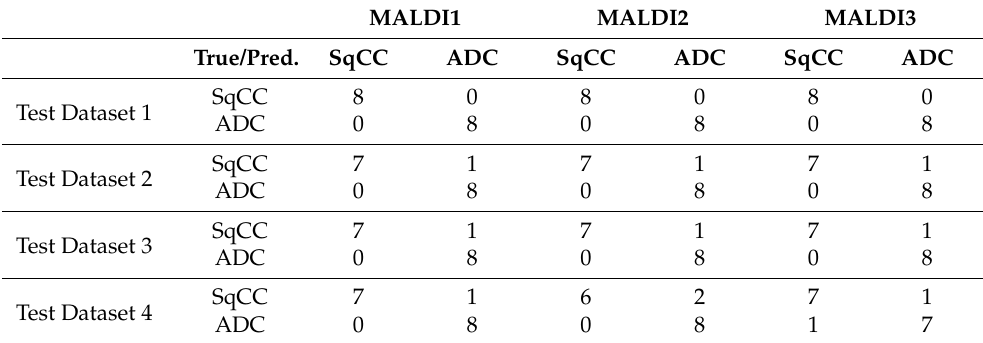
Table A4. Confusion matrices of classification with different MALDI networks on different test datasets on the section level (Pred. = Prediction). Section-wise classification based on the majority vote ( p = 0.5 ). The diagonal elements of the matrices show the number of correctly classified sections, off-diagonal elements show the number of misclassified sections. Explanation of different datasets can be found in Table